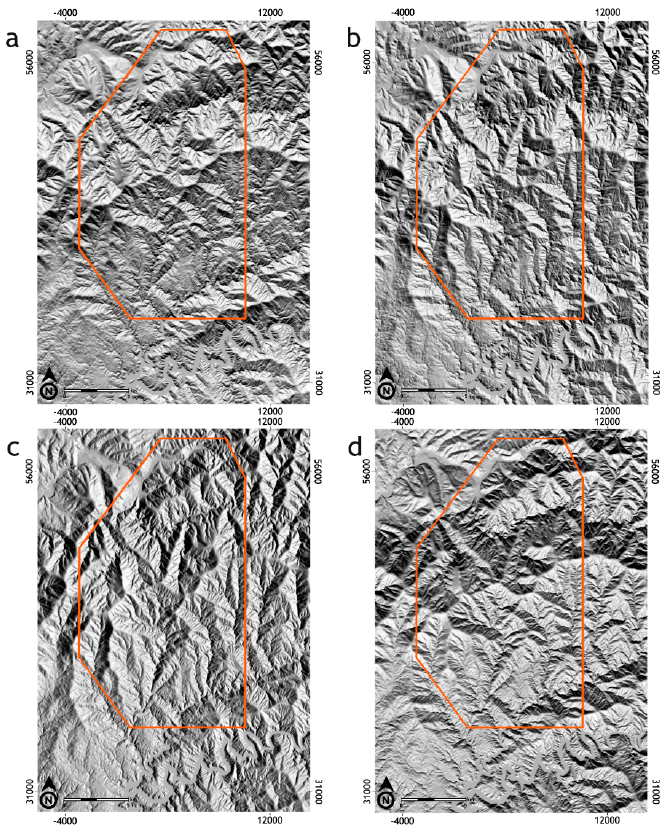
Figure 9. Hill shade relief maps. Artificial illumination: ( a ) N–S; ( b ) NE–SW; ( c ) E–W and ( d ) SE–NW. Original elevation data from the Portuguese Military Cartography at 1:25,000 scale.